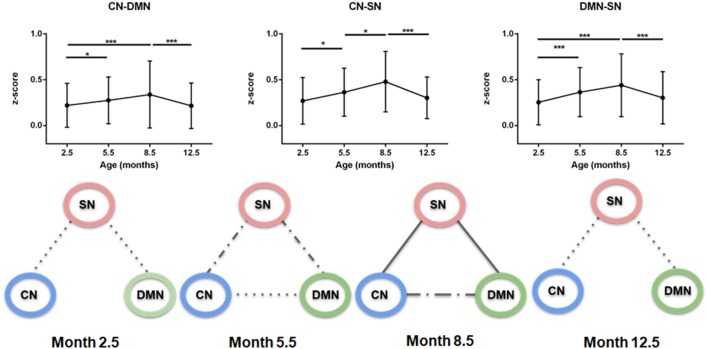
Inter-network connectivities. Upper row: z-scores of connections between cortical network (CN), subcortical network (SN) and default mode network (DMN). There is a significant increase of connectivity until 8.5 months, followed by a decrease until month 12.5 in all cases. Lower row: schematic representation of the strength of correlations over time. Each graph, from left to right, represents a specified age (2.5, 5.5, 8.8 and 12.5 months). Solid line, z-score > 0.41; Dash-dotted line, z-score > 0.33; Dotted line, z-score > 0.25; No line, z-score < 0.25. CN-SN and SN-DMN connections show a higher correlation over time than the CN-DMN connection (p < 0.001). Error bars indicate SD. *p < 0.05 and ***p < 0.001.